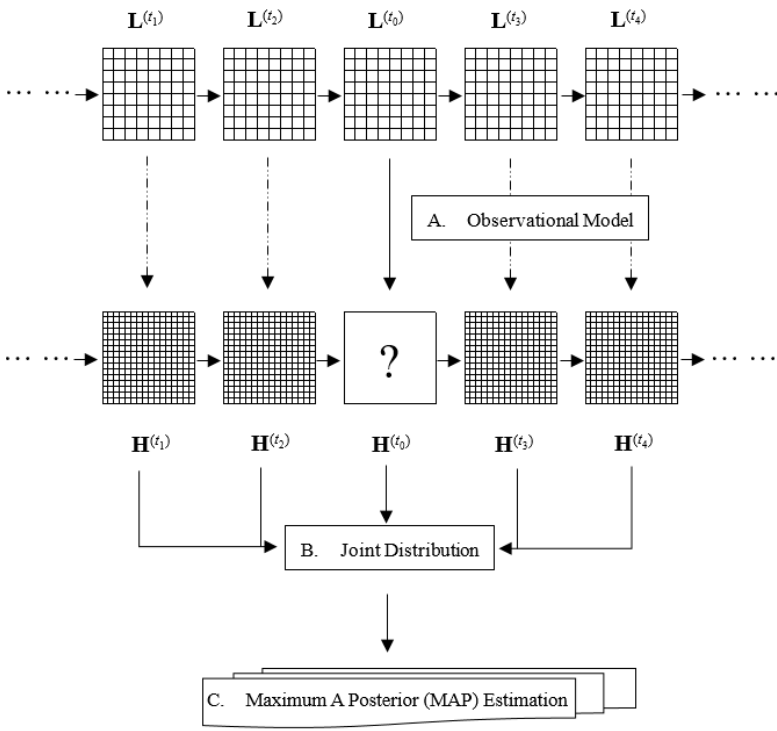
Figure 1. The general framework of Bayesian data fusion using quadruple pairs. It should be